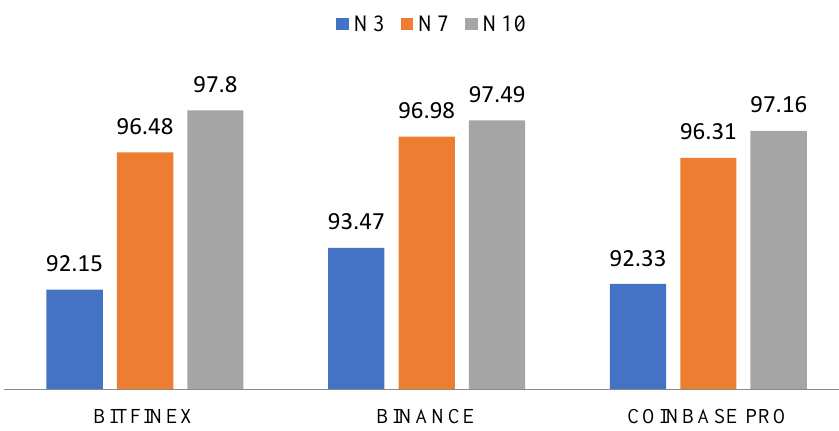
Figure 12. RMSE gain percentage in the three datasets.